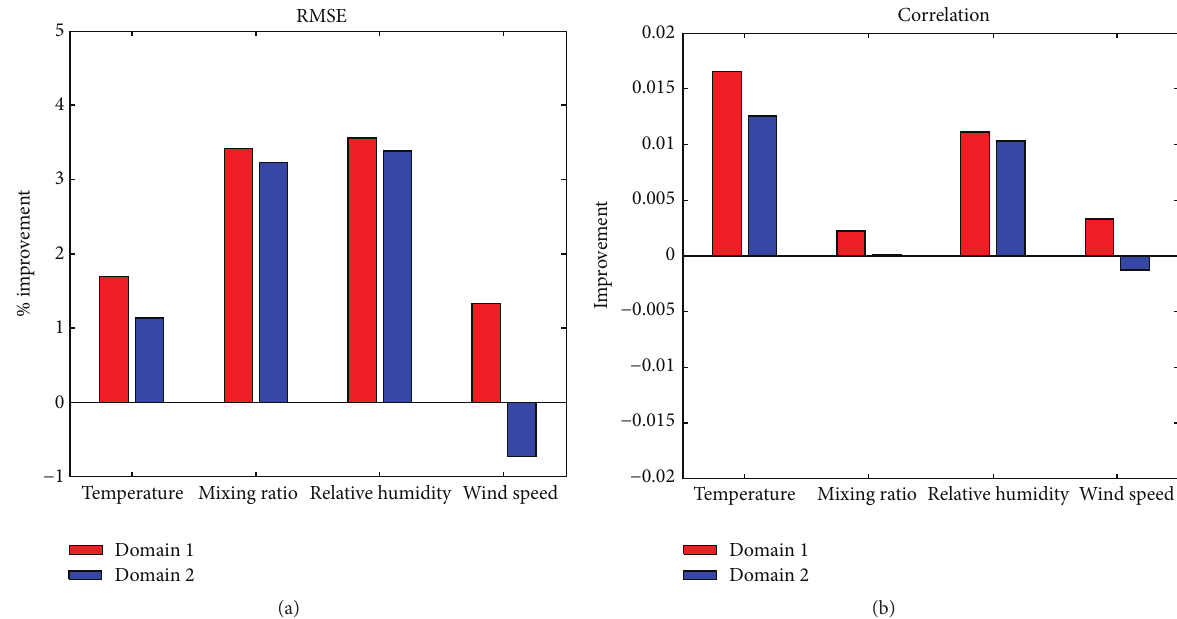
Figure 3: (a) Percentage improvements for root mean squared error (RMSE) and (b) correlation improvement for temperature, mixing ratio, relative humidity, and wind speed due to the assimilation of the TAMDAR data (Domain 1: red bars; Domain 2: blue bars). The abscissa represents the variables while the ordinate represents the improvement. The statistics are averaged over all sounding locations, the 400– 600 hPa layer, and the 6-day (August 1 through August 6) simulation